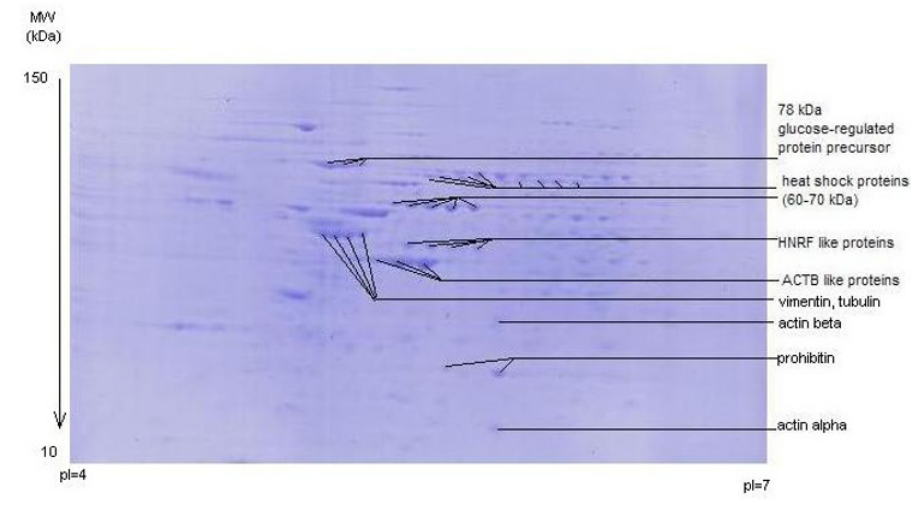
Figure 1. 2-D map of nuclear proteins of MCF-7 cells on IPG strip with gradient of 4 – 7 (7 cm